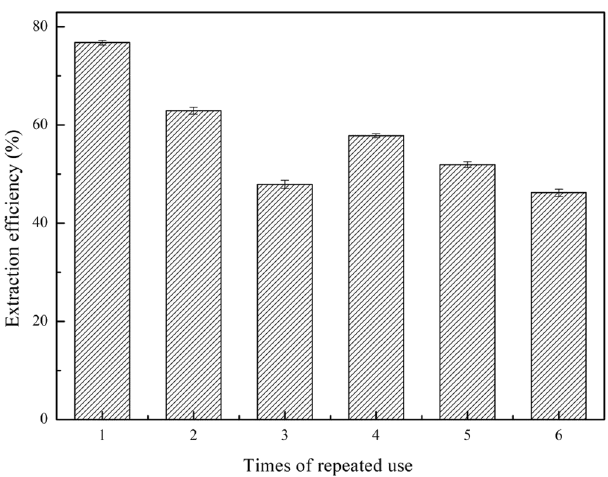
Figure 10. The effect of repeated use on the extraction efficiency (experimental conditions: 1.2 g (TBAC/2p- TsOH)/rGO, 0.5 g simulated oil (1600 mg/L sulphur content), 0.25 g H 2 O 2 , 25 °C, 800 rpm, 60